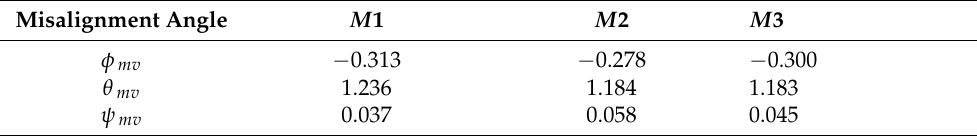
Figure 14. Estimation results during the figure eight manoeuvre of Figure 13 for both estimators (A) and (B). Additionally, in green, the parameter estimates obtained with estimator (A) based on the data corrupted by the artificial misalignment error ( 0.7,0.5,1.2 ) deg for φ mv , θ mv and ψ mv , respectively, and the artificial bias errors ( 0.1,0.1, − 0.2 ) m/s 2 for b f , b f and x y Ω Σ − 1 b f , respectively. Finally, the determinant of the excitation matrix W p , k = Ω T k is depicted in the last sub-plot. k k z Table 6. Estimation results of (A) for three different figure eight manoeuvres driven on different days. | ≈ 4 m M 1 is the manoeuvre displayed in Figure 13 with | ˜ f m , M 2 represents a less dynamic iv , y max s 2 | ≈ 3 m Figure 8 drive with | ˜ f m and M 3 corresponds with a more dynamic Figure 8 drive with iv , y max s 2 | ˜ f m | ≈ 5 m iv , y max s 2